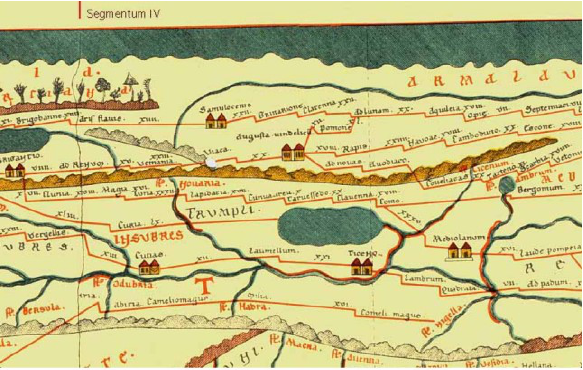
Figure 1. Detail of the Peutinger Map, in which Via Regina is represented as a stepped red line North of the lake In Roman times, the longitudinal way on the north-south route of the lake assumed increasing importance with the expansion to the north of the achievements and boundaries. Base point and a sign of this new importance was certainly the new urban settlement of Comum, built on the shores of the current Como Lake. At first the main passage was formed by the natural lake route and then, from the imperial age, by land route of the western shore, only much later called Via Regina ('Royal Road'), a main public street documented for the first time with this name in